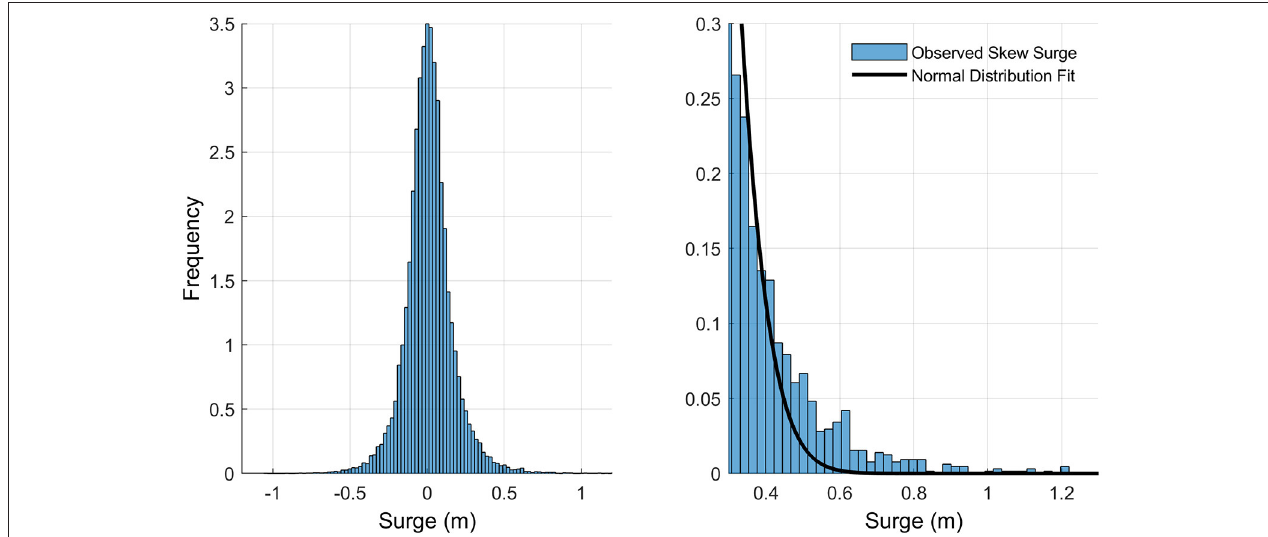
FIGURE 2 | Example demonstrating the “fat tail” nature of skew surge distribution for the NOAA tide gauge at Lewes, DE. Histogram includes all detrended skew surges over 1980–2019 (left panel). Upper tail of the same data with Normal distribution model fitted to all data points (right panel). Note the upper tail of the theoretical parent distribution under-represents empirical skew